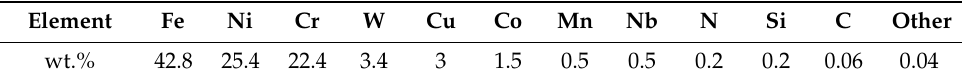
Table 1. Chemical composition of Sanicro 25.